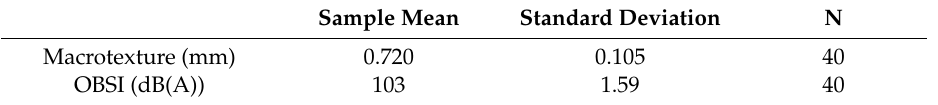
Table 4. Statistical description of macrotexture and OBSI of transverse groove concrete pavement.